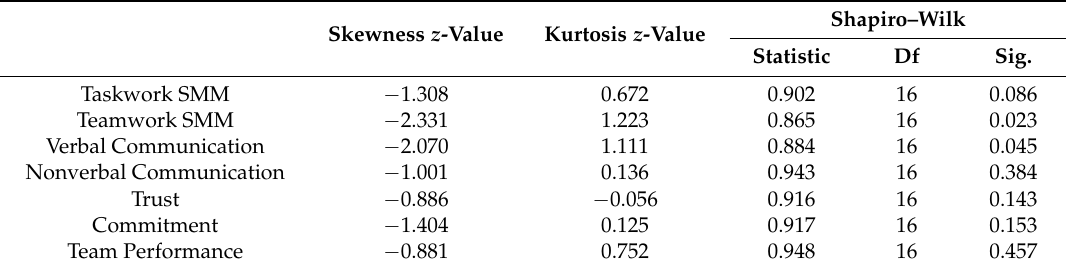
Table 2. Normality tests: skewness, kurtosis, and Shapiro–Wilk.